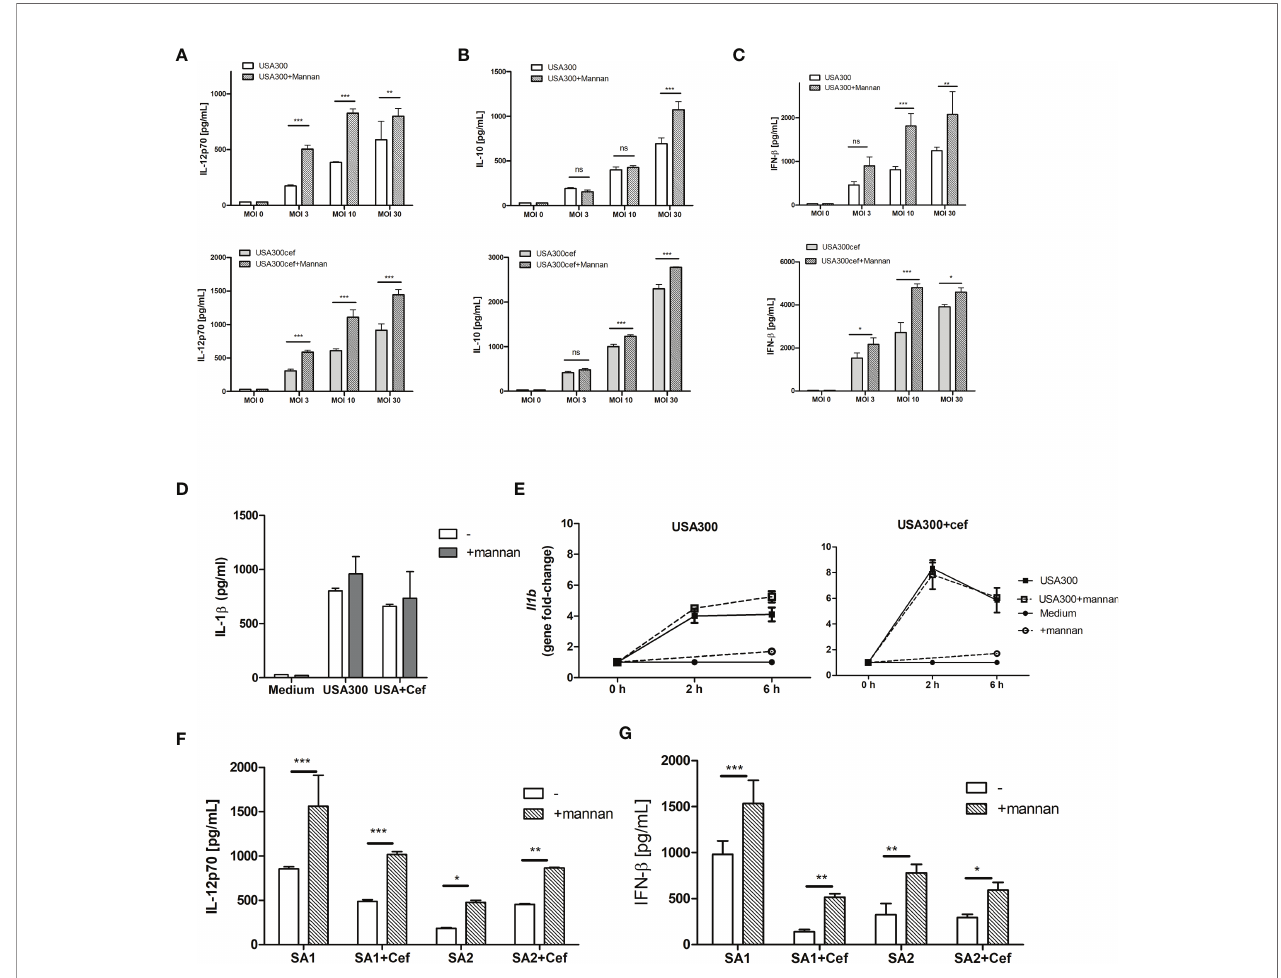
FIGURE 1 | Mannan increases IL-12 and INF- b production in USA300-stimulated DCs. DCs were pre-treated or not with mannan (100 µg/ml) 30 min prior to infecting with UV-treated USA300 or cefoxitin-grown USA300 at MOI 3, 10 and 30. IL-12 (A) , IL-10 (B) , IFN- b (C) were measured in supernatant by ELISA, n=3 (SD) wells for each treatment. IL-1 b production after stimulation with MOI 10 (D) , and Il1b expression at 0 h, 2 h and 6 h (error bars based on two technical replicates) (E) . DCs were pre-treated or not with mannan 30 min prior to stimulation with the clinical MRSA SA1 and SA2 grown with or without cefoxitin, IL-12 and IFN- b was measured in supernatant after 20 h (F, G) , n=3, error bars: SD. 2-way ANOVA was performed, *p < 0.05, **p < 0.01, ***p < 0.001. ns, non-signi fi cant. All data shown are representative data of one out of at least 3 independent